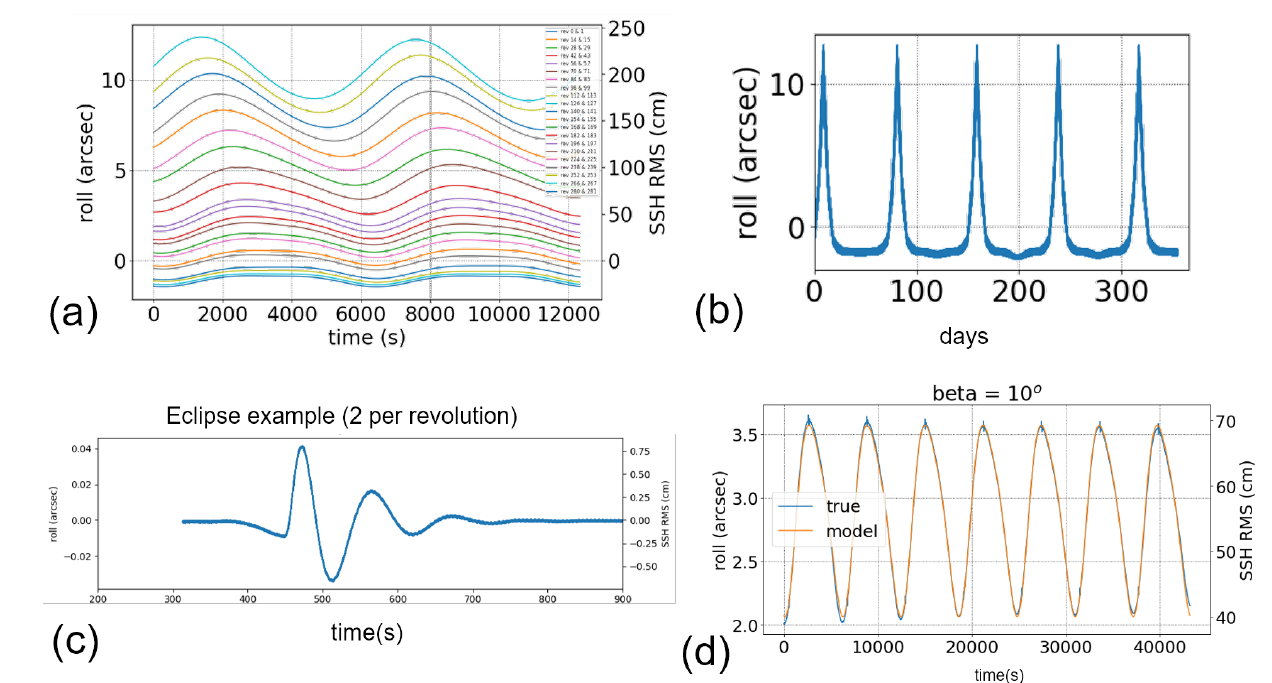
Figure 6. Simulation of the systematic attitude knowledge error (excluding the random component from the gyrometer).